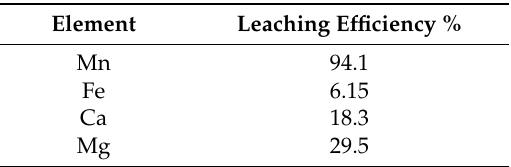
Table 2. Leaching efficiency of main elements in